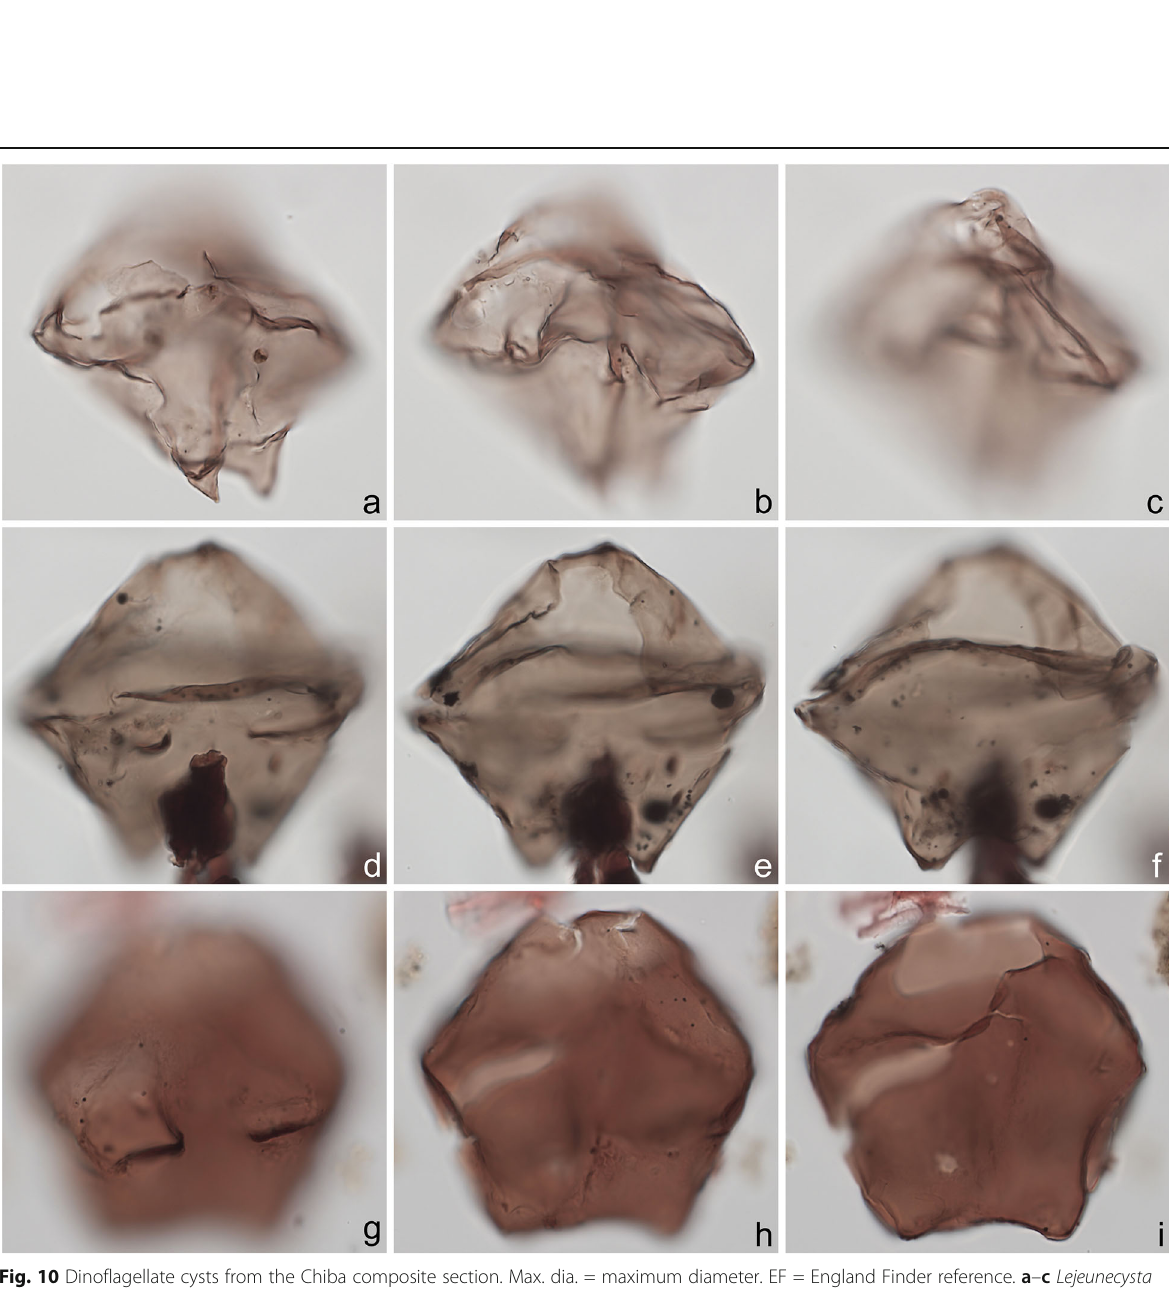
Fig. 10 Dinoflagellate cysts from the Chiba composite section. Max. dia. = maximum diameter. EF = England Finder reference. a – c Lejeunecysta sp. A, dorsal view at upper, mid-, and lower foci; cyst length 67 μ m; sample TB 50, slide 2 (10 μ m), EF O40/3. d – f Lejeunecysta sp. B, ventral view at upper, mid-, and lower foci; cyst length 78 μ m; sample TB2 59, slide 2 (10 μ m), EF R37/1. g – i Quinquecuspis concreta , ventral view at upper through lower foci; cyst length 75 μ m; sample TB 16, slide 2 (10 μ m), EF N37/0